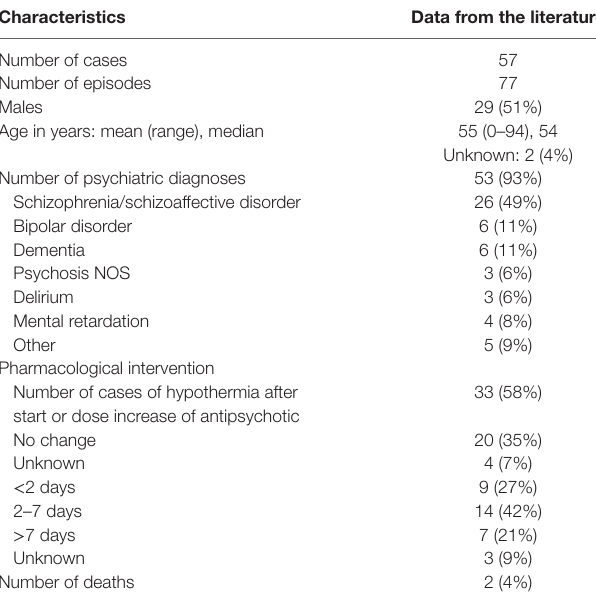
following antipsychotic drug use.